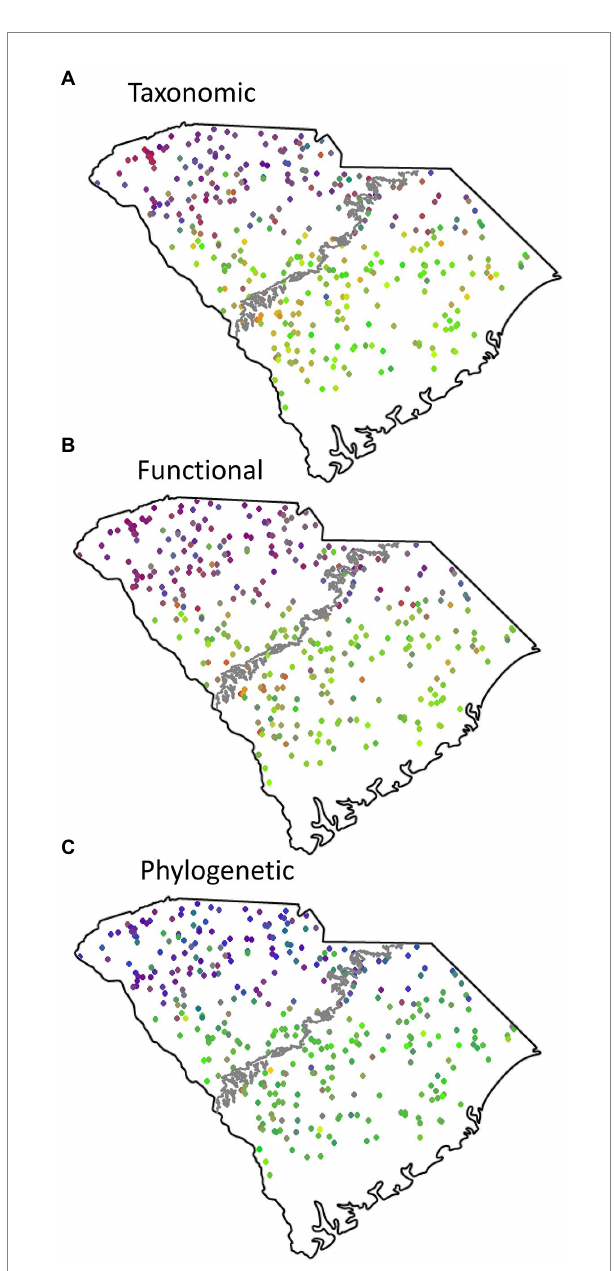
FIGURE 4 Red, green, blue (RGB) plots of fish beta diversity over taxonomic (A) , functional (B) , and phylogenetic (C) diversity dimensions. Similar colors reflect communities with similar species compositions, while differing colors reflect increased differences in species composition between